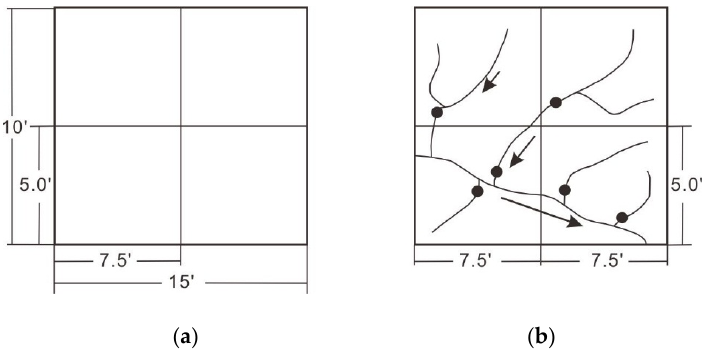
Figure 2. Grid cell ( a ) and sample location layout ( b ). Black arrows indicate the directions of the river.